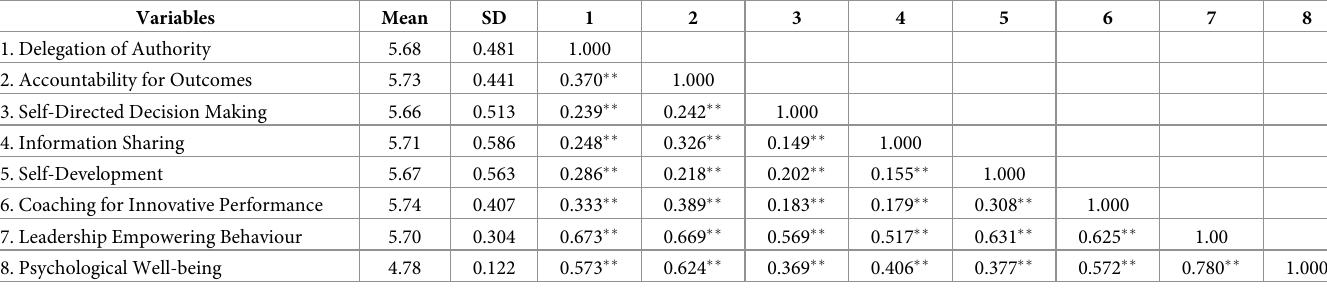
Table 6. Pearson’s product-moment correlation analysis between leadership empowering behaviour and teachers’ psychological well-being. Variables